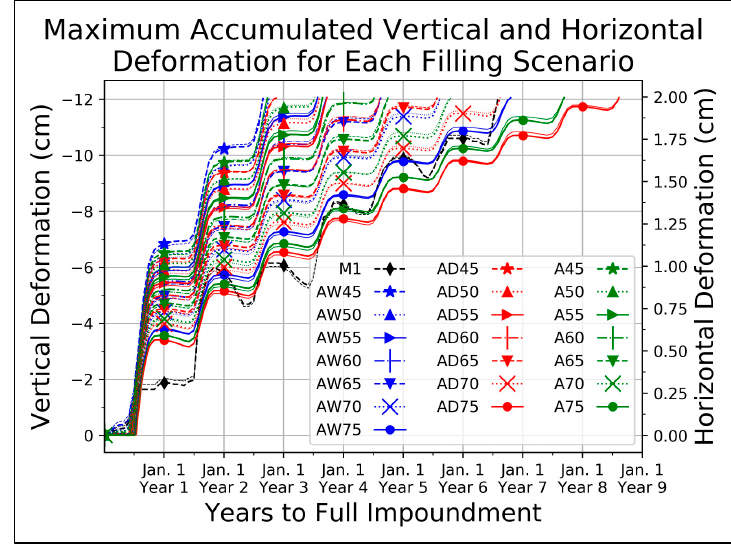
Figure 3. Accumulated daily vertical and horizontal displacements from 22 different filling scenarios. The horizontal displacement on the second y-axis is marginally offset from the vertical displacement on the first y-axis and is plotted as the slightly minor lines of the same symbology for each of the filling scenarios.